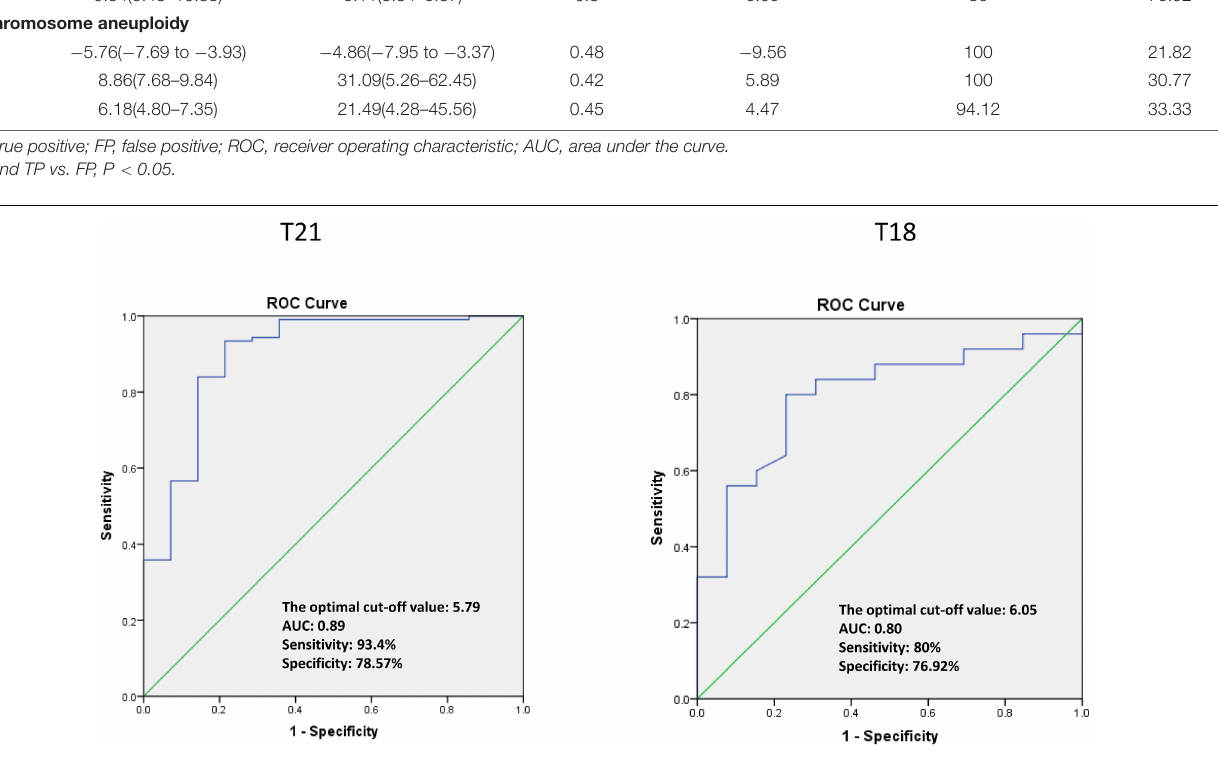
FIGURE 1 | The ROC curve analysis of pregnancies with trisomy 21 and trisomy 18. TABLE 4 | The positive predictive value (PPV) and false discovery rate (FDR) performance of NIPS positive results with T21,